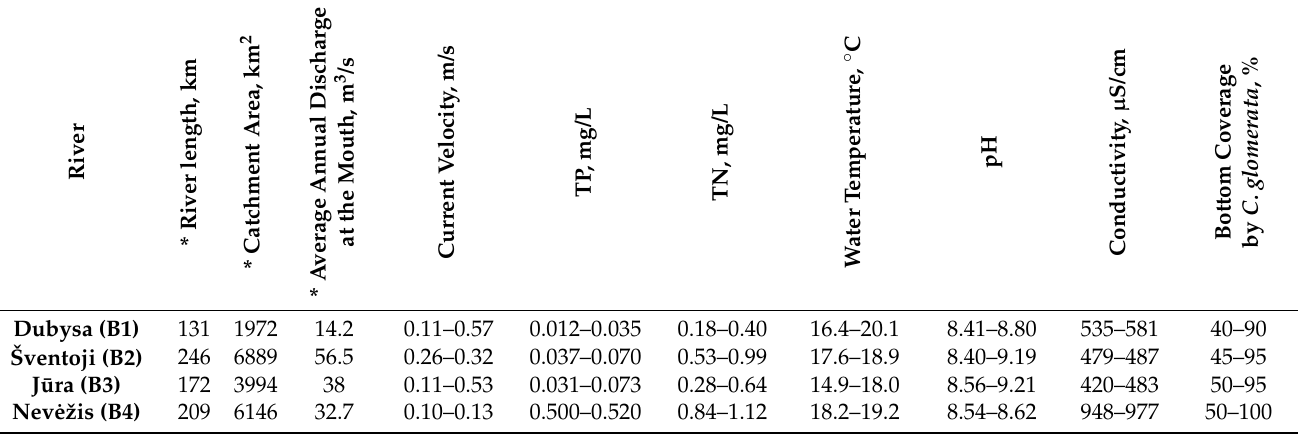
Figure 1. ( A ) The locations of C. glomerata biomass collection in the rivers of Lithuania; ( B ) Agglom- erations of macroalgal C. glomerata biomass in River Nev˙ežis; ( C ) Collection of C. glomerata biomass; ( D ) Dried biomass of macroalgae. Table 1. Characteristics of the rivers and the abundance of Cladophora macroalgae at the sampling